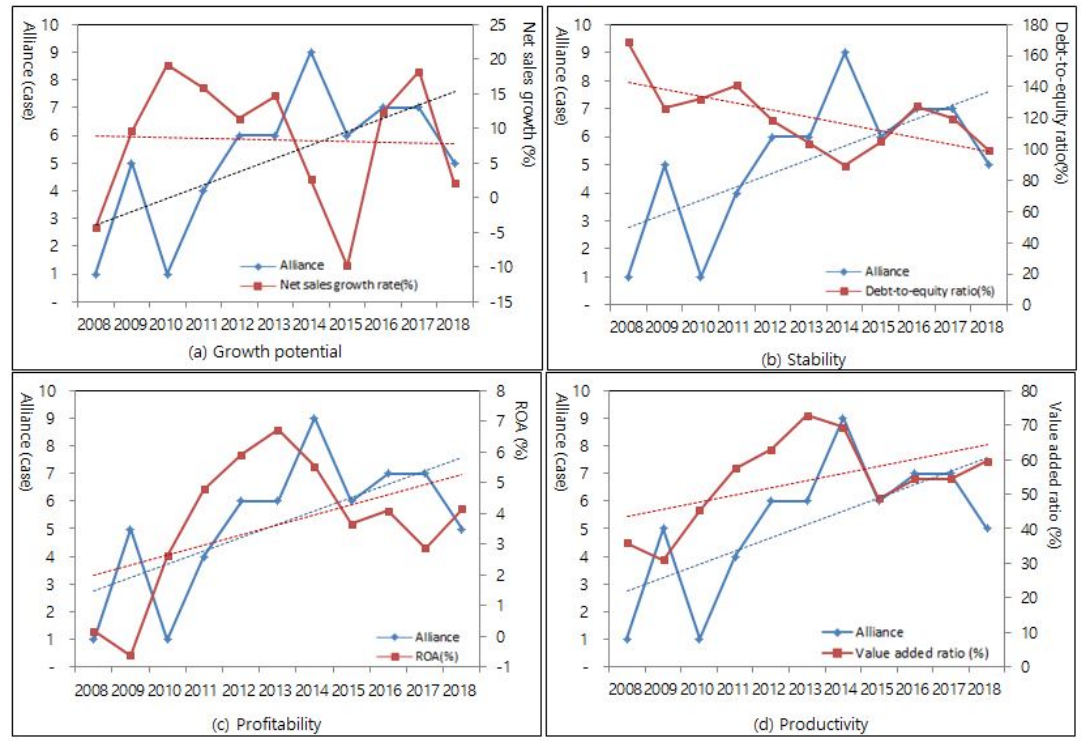
Figure 3. Analysis of Daesang’s financial ratio.